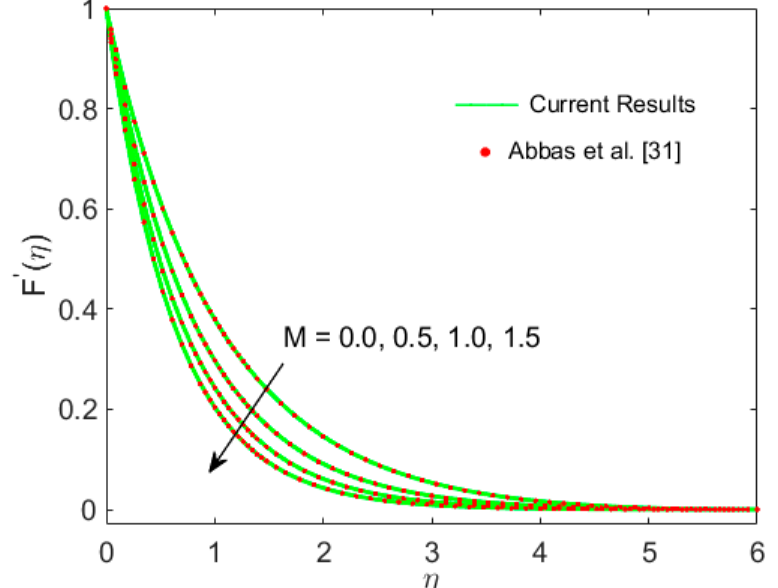
( ) ' F η for different values of M when Figure 2. Comparison of the velocity profile F (cid:48) ( η ) for different values of M when γ = ∞ , φ 1 = φ 2 = S 1 = 0, Figure 2. Comparison of the velocity profile λ = 1, W = . Table 1. Thermophysical properties of blood and gold nanoparticle [32].